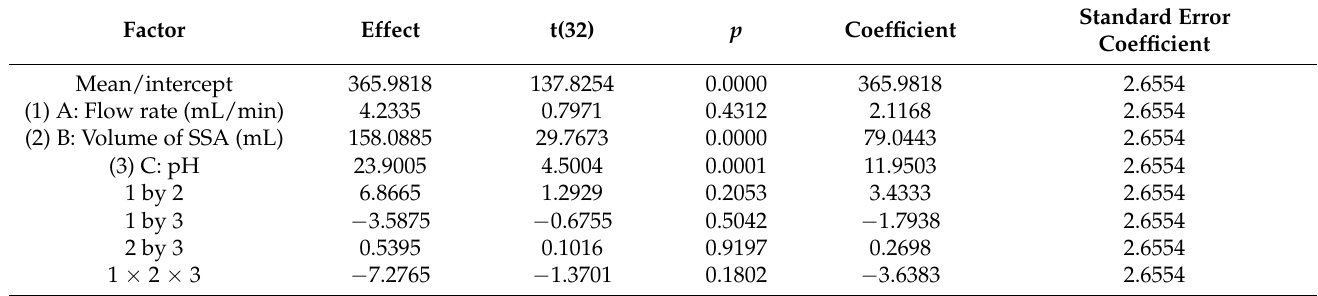
Table 7. Results of the statistical analysis for in vitro release rate (IVRR) ( µ g × cm − 2 × min − 0.5 ).